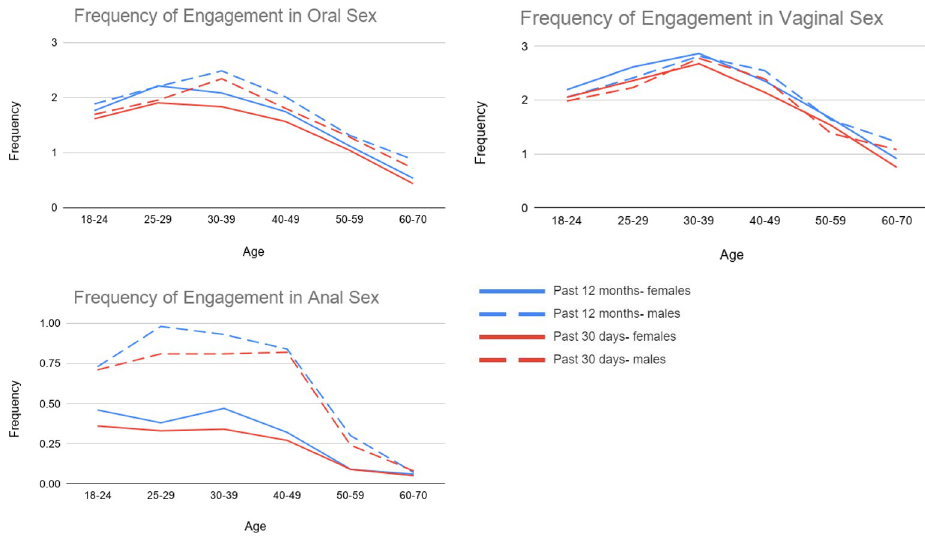
Fig 2. Age trends in the mean frequency of oral, vaginal, and anal sex in the past 12 months and past 30 days ( N = 1,987; men n = 953, women n = 1015).